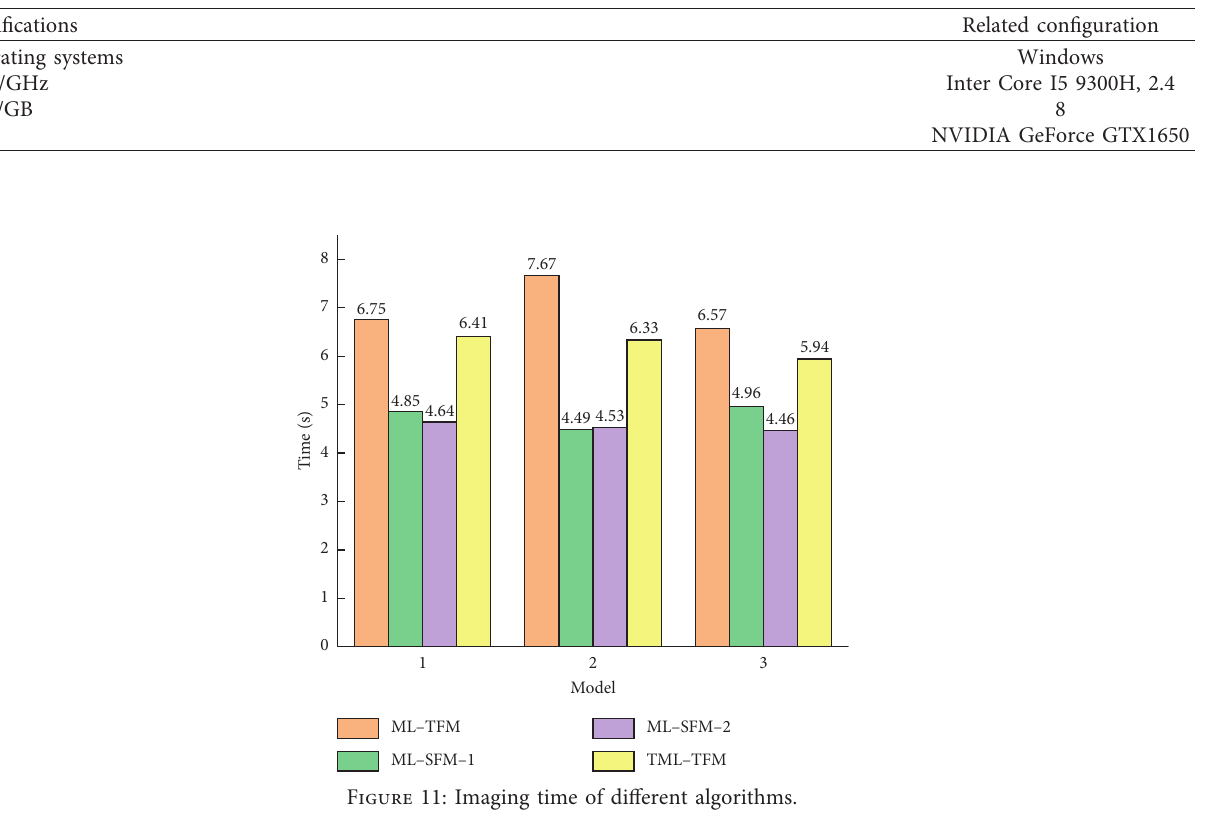
Figure 10: SNR of different algorithms. Table 2: Platform configuration.